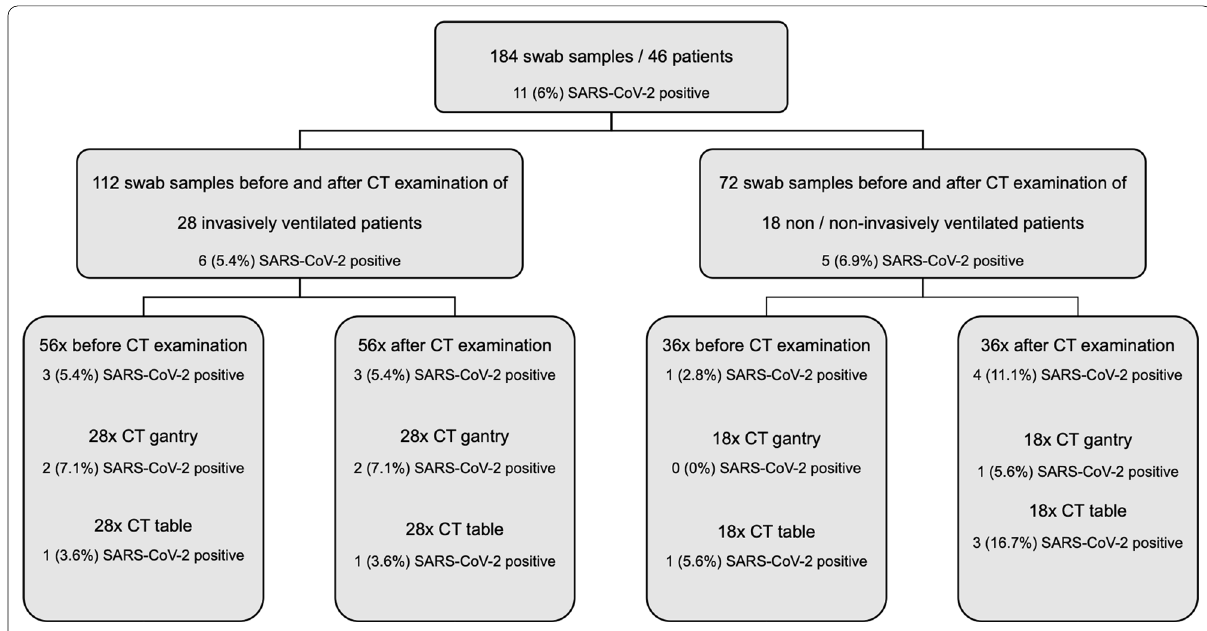
Fig. 2 Visualization of the sampling process from patient near surfaces (CT table/CT gantry). SARS-CoV-2: severe acute respiratory syndrome coronavirus type 2; SARS-CoV-2 positive: number and percentage of positive RT-PCR results for SARS-CoV-2